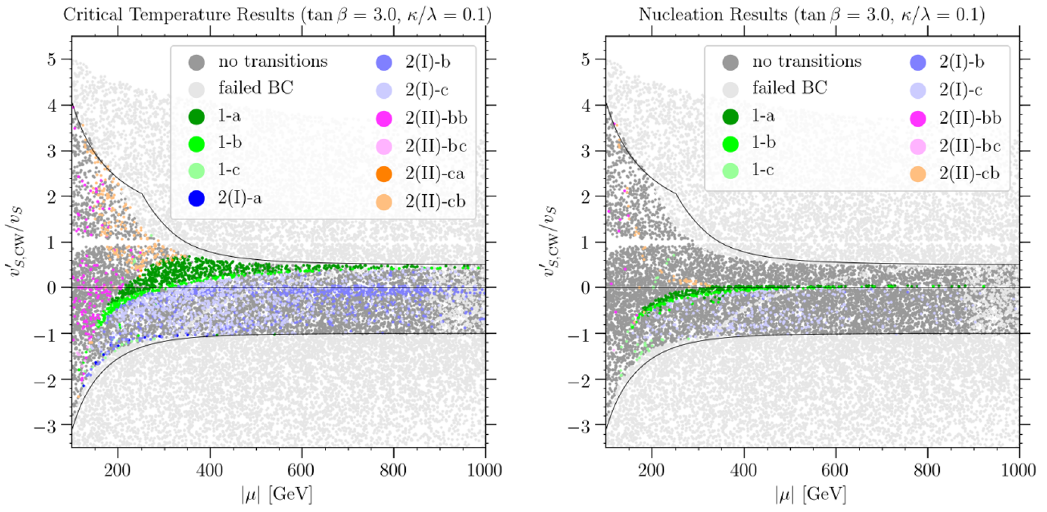
Figure 7 . Same as figure 4, but for tan β = 3 . 0 and κ/λ = 0 . 1